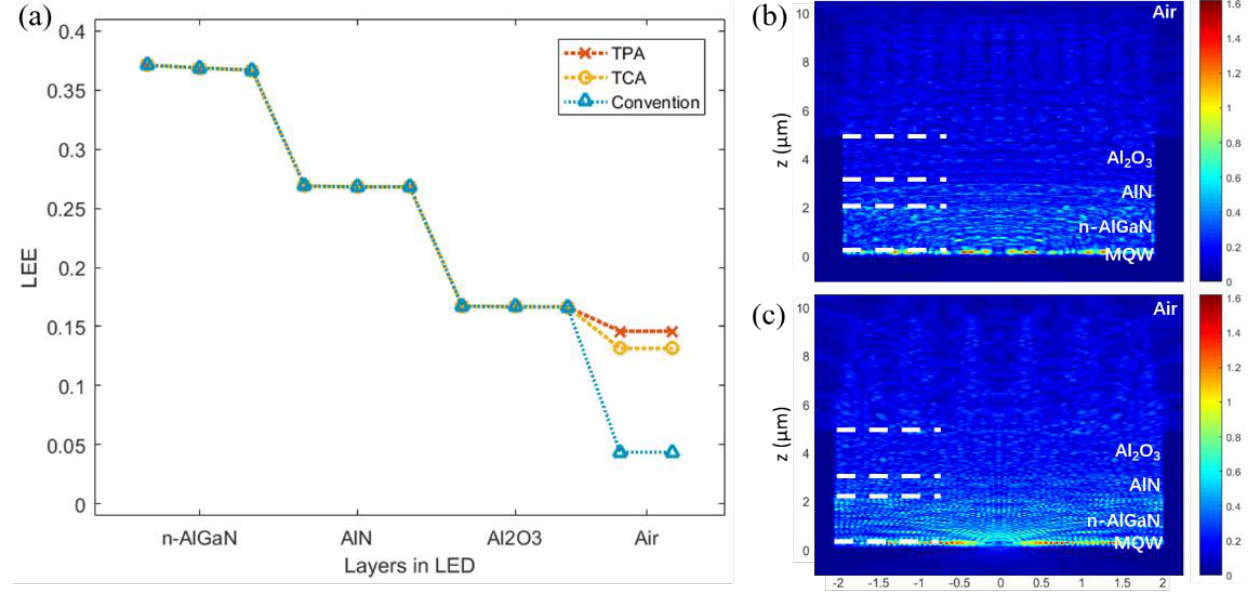
Figure 4. ( a ) The comparison of LEE decrement trends along LED layers, and the field distributions in the LED cross section with ( b ) TPA and ( c ) TCA. in the LED cross section with ( b ) TPA and ( c )